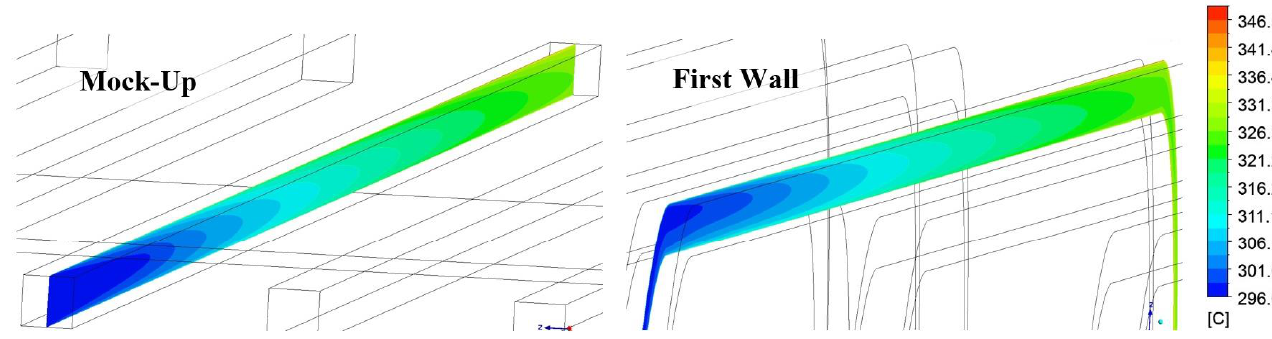
Figure 7. Temperature field in a vertical central section of the reference channel fluid .